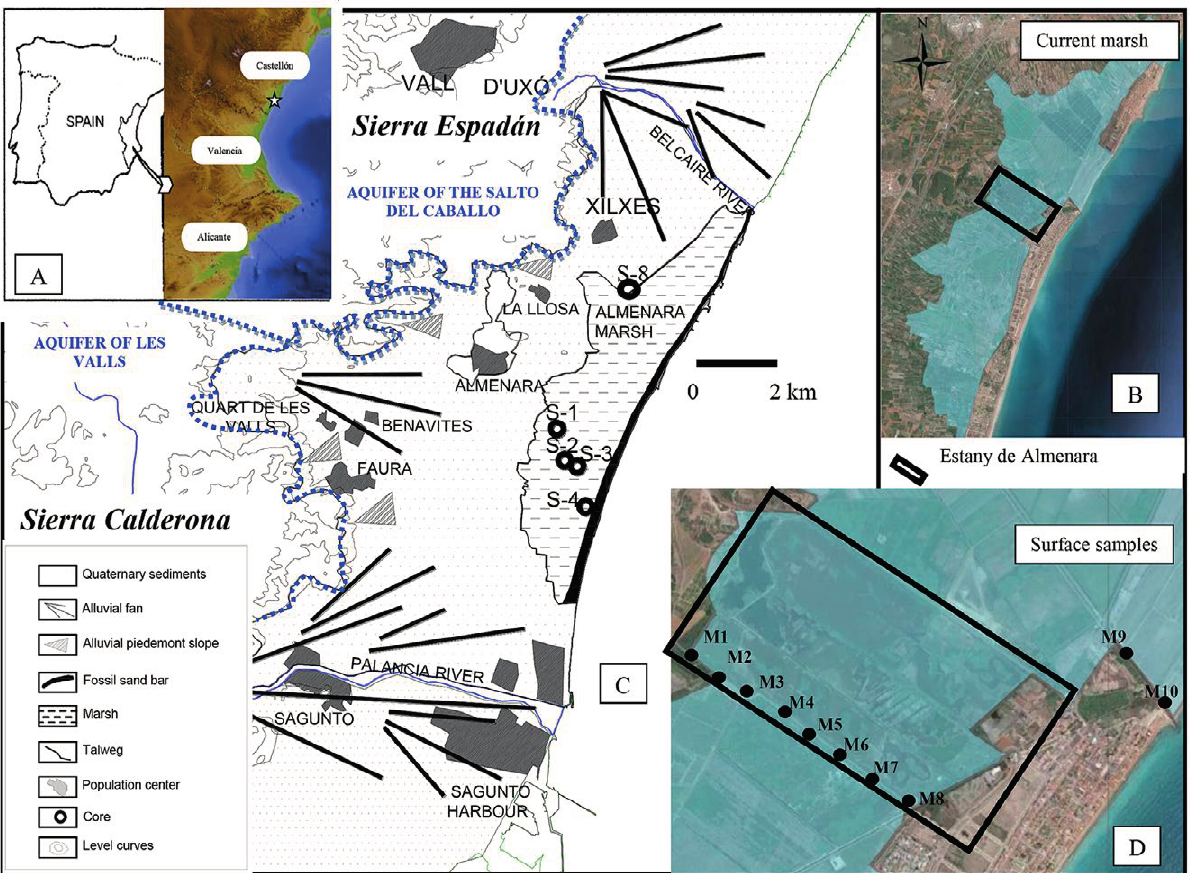
Fig. 1. – A, location of the study area. B, geomorphological map and situation of the mechanical cores and surface sediment samples. C, wetland reclaimed. D, location of the surface